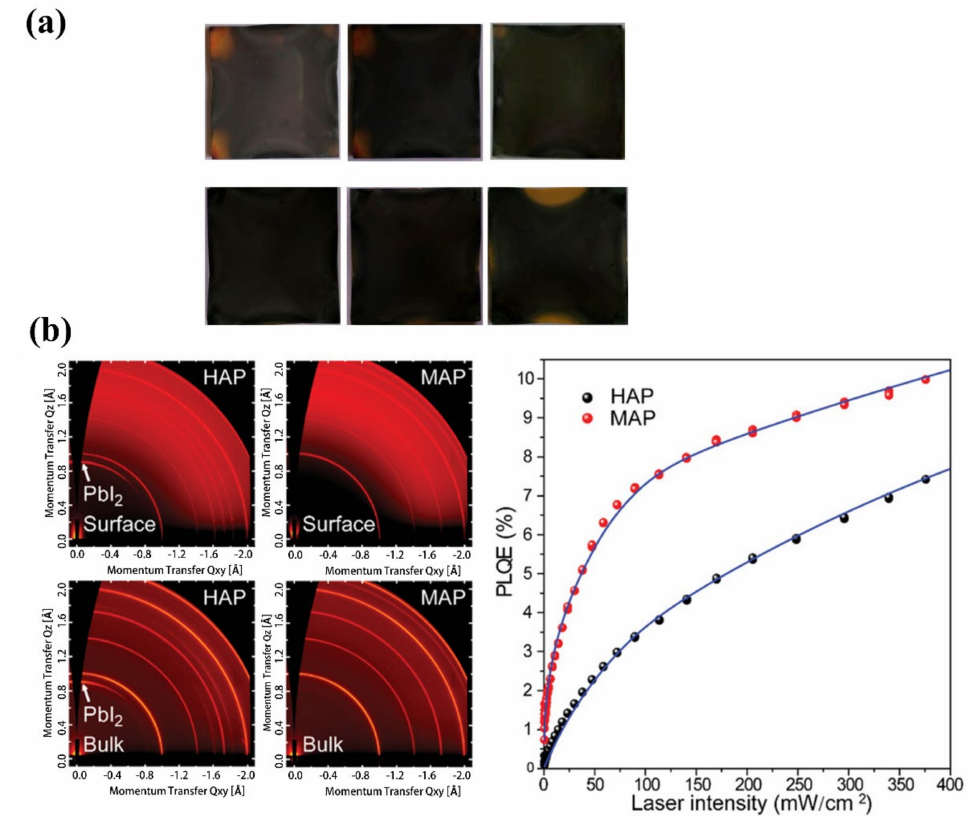
Figure 10. ( a ) The color evolution of MAPbI 3 - x Cl x perovskite samples for various radiation times in the microwave annealing process: 3 min, 4 min, 5 min, 6 min, 8 min and 10 min. (Reprinted with permission from Ref. [108]. Copyright 2016 Elsevier B.V). ( b ) Microwave annealed and